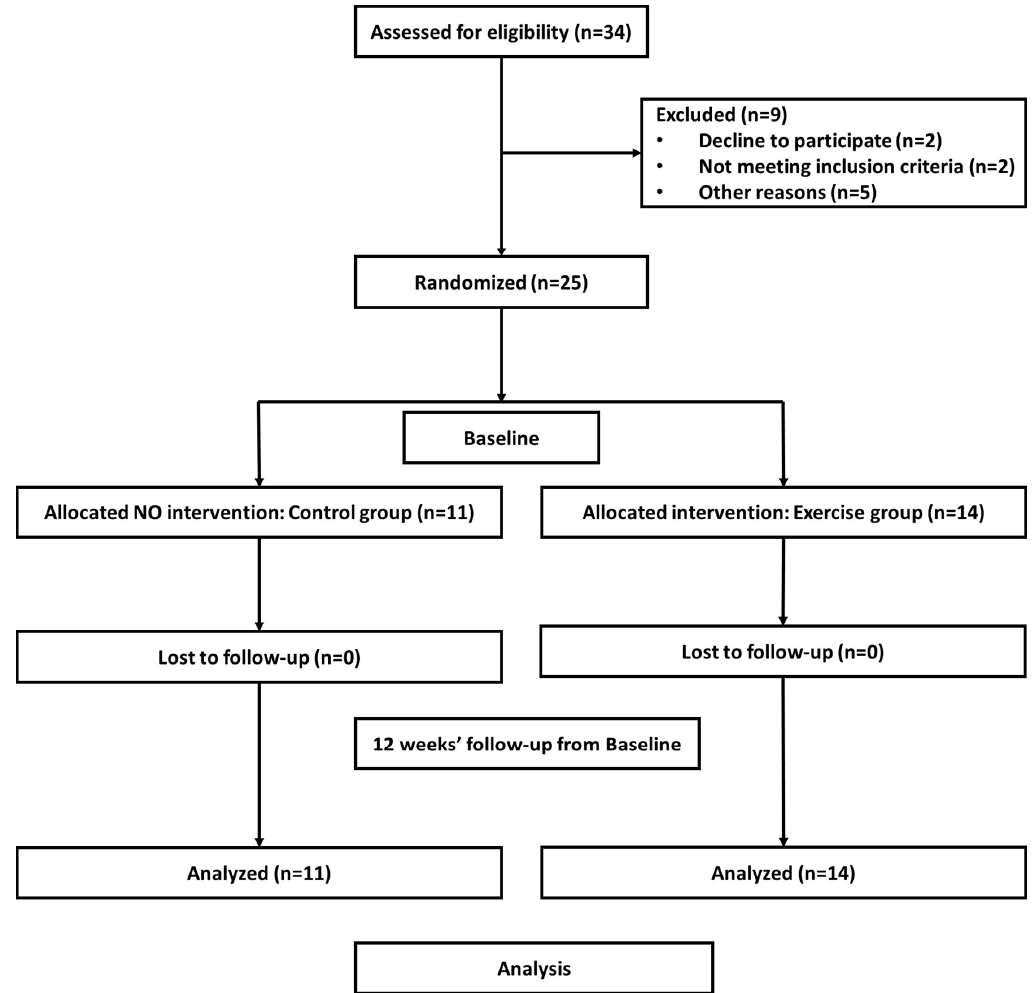
Figure 1. Flow diagram of the study.